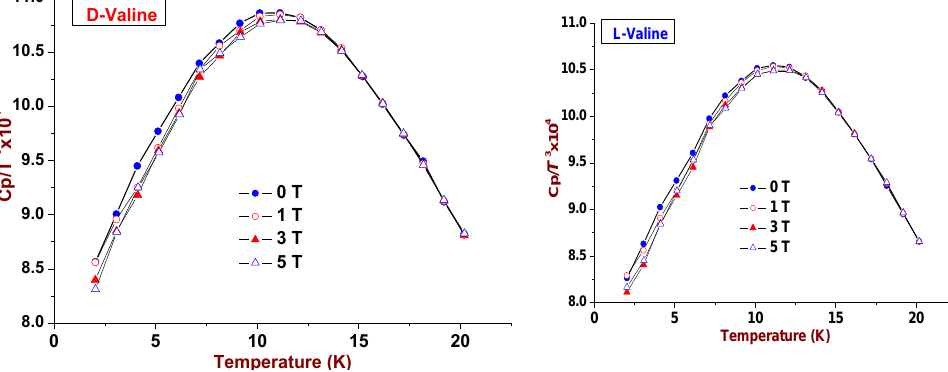
Figure 5. Temperature dependence of the heat capacities C p / T 3 of D -, L -valine. Crystals as a function of external magnetic field with H//b axis.